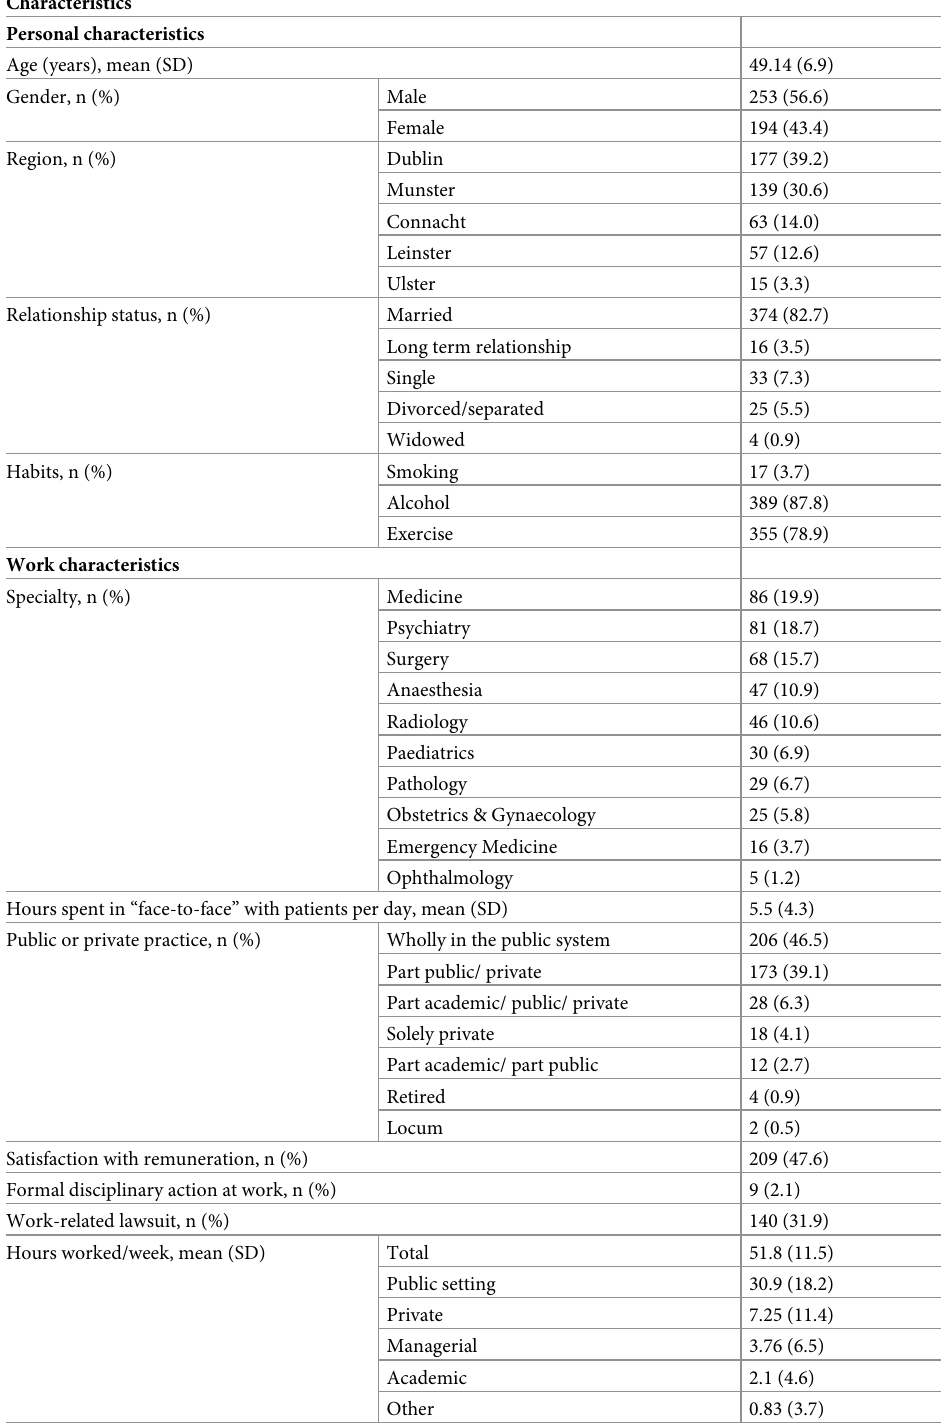
Table 1. Demographics and work related